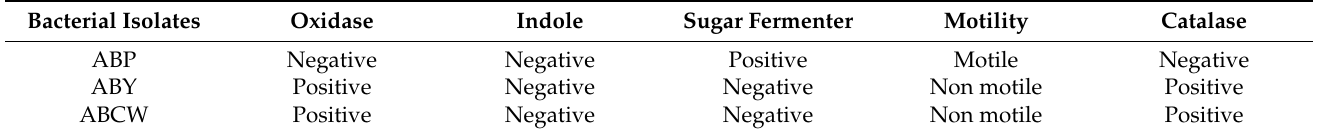
Table 4. Biochemical Tests for Bacteria